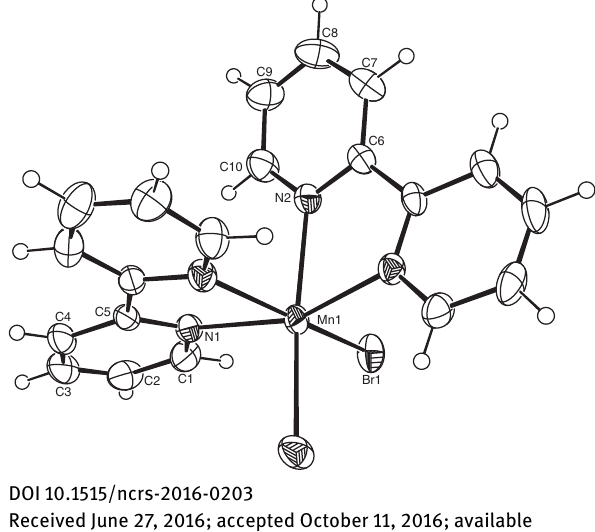
Table 1: Data collection and handling.